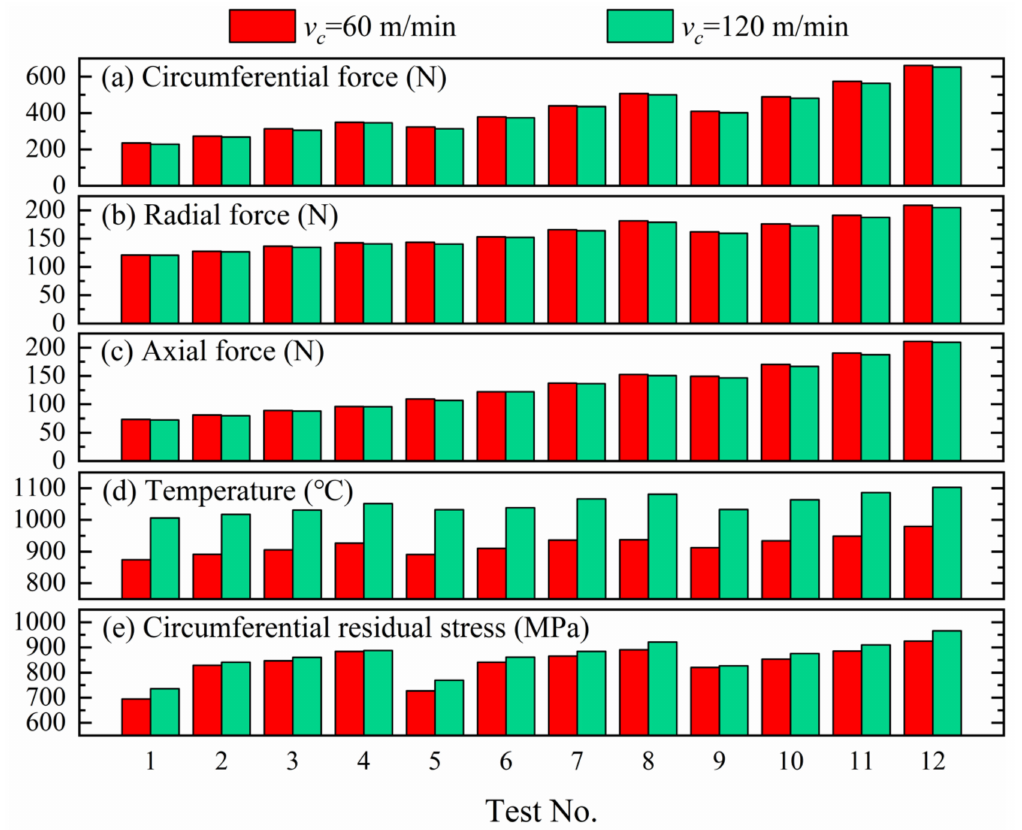
Figure 7. ( a ) The comparison of the circumferential forces at 60 and 120 m/min. ( b ) The comparison of the radial forces at 60 and 120 m/min. ( c ) The comparison of the axial forces at 60 and 120 m/min. ( d ) The comparison of the cutting temperatures at 60 and 120 m/min. ( e ) The comparison of the circumferential residual stress at 60 and 120